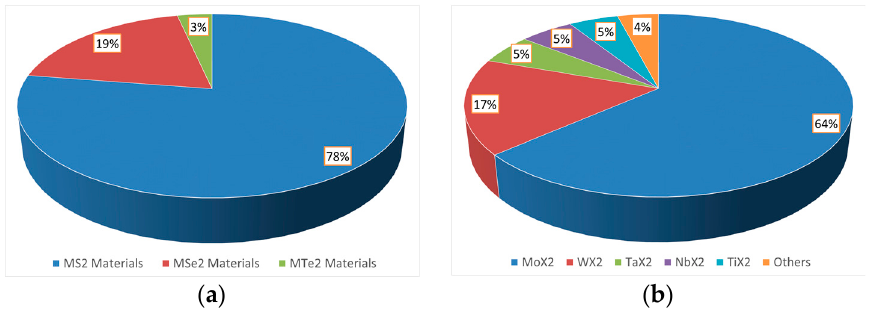
Figure 2. ( a ) Percentage of M S 2 (in blue), M Se 2 (in red) and M Te 2 (in green) manuscripts; and ( b ) chart reporting the percentage of most common transition metals investigated as TMDs. (source SCOPUS, Elsevier B.V.).